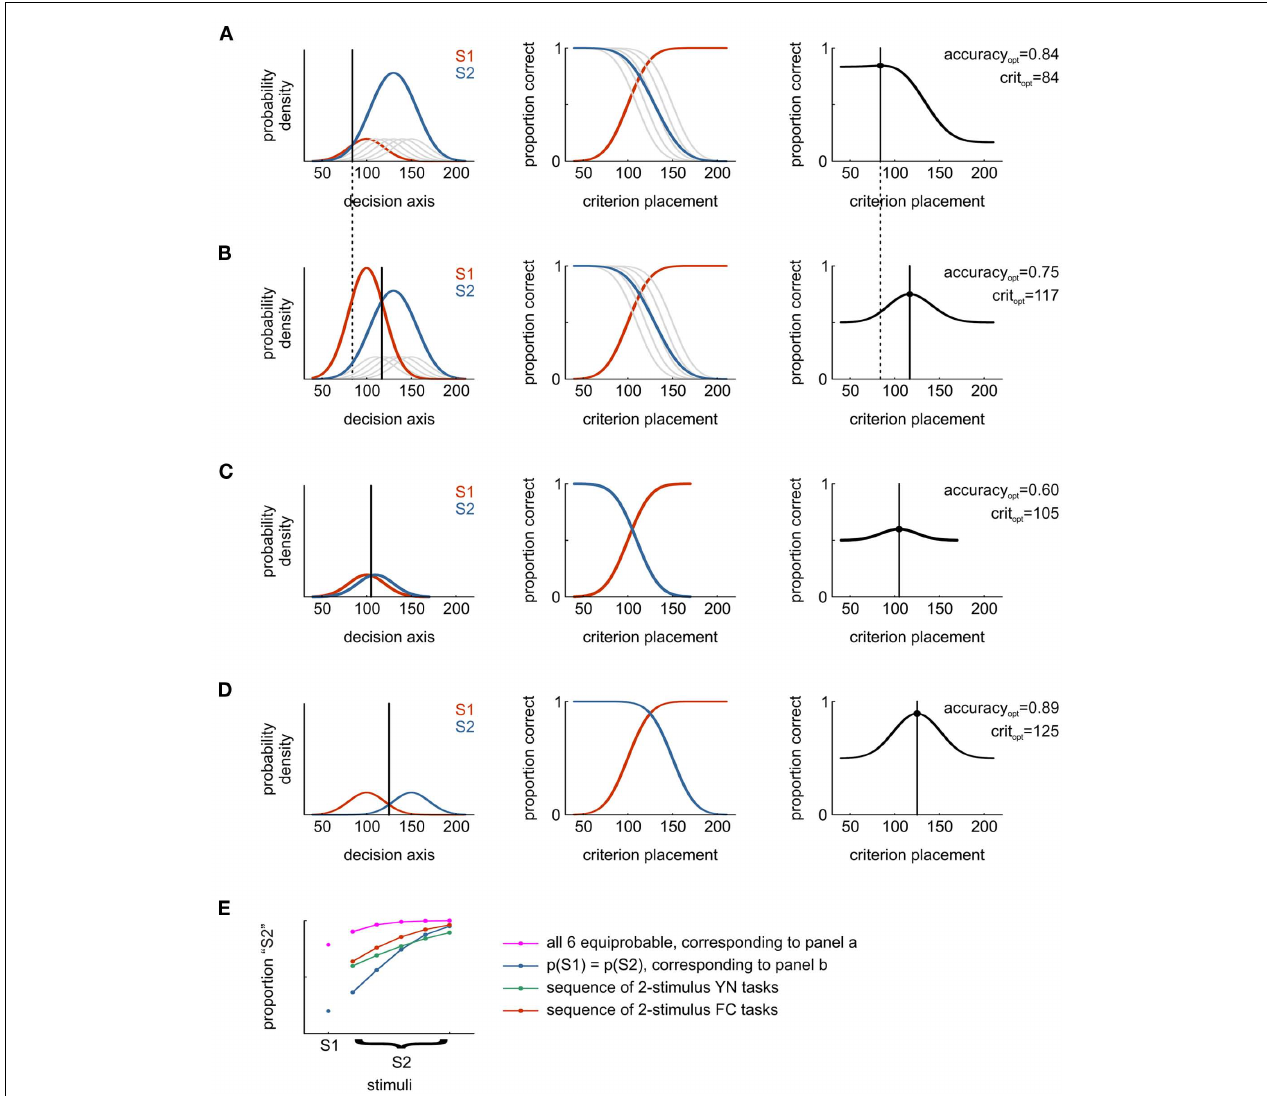
within the S2 category, all stimuli are equally probable (p = 0.1). For the same set of stimuli as in a, the optimal criterion is shifted considerably to the right, and the overall proportion of correct responses drops from 0.84 to 0.75. (C) As in (A) , but showing performance in a two-stimulus yes/no task with S1 and one stimulus out of S2 with the weakest signal strength. (D) As in (A) , but showing performance in a two-stimulus yes/no task with S1 and one stimulus out of S2 with strongest signal strength. (E) Psychometric functions for different task conditions: magenta, task as in (A) , blue, task as in (B) , green: psychometric curve resulting from a sequence of separate yes/no experiments where stimuli are presented pairwise and in blocks (i.e., S2 vs. S1–S1, S2 vs. S1–S2, S2 vs. S1–S3 etc.), red: psychometric curve resulting from a sequence of 2-AFC experiments where stimuli are presented pairwise and in